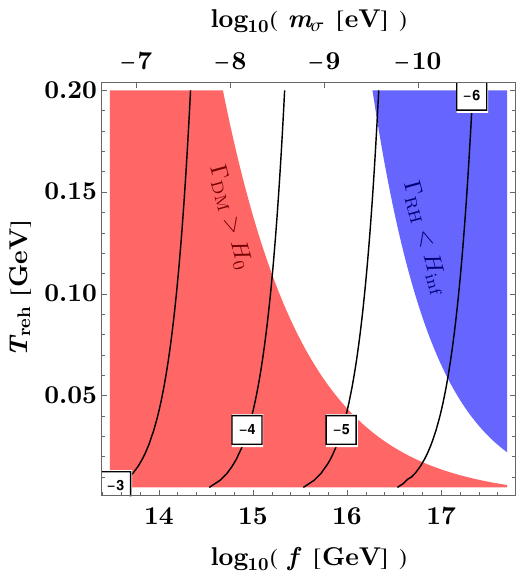
Figure 4 . Parameter space of the QCD axion in terms of its decay constant f , mass m σ , and reheating temperature T reh . To simplify the analyses, T reh is taken to be below the QCD scale; with such extremely low reheating temperatures, the axion window shown here should be considered as a proof of concept (see the main text for discussions). Regions where the QCD inflaxion can make up the dark matter is shown in white. The colored regions are excluded from the requirements of dark matter stability (red) and instantaneous reheating (blue). The lower end of the displayed T reh region is set by BBN. The inflaton-axion mixing constant is fixed to α = 1 / 2, and the inflaton 10 − 3 . Black solid contours show the inflaton mass in terms is coupled to fermions with g φff = 5 × ( m φ / of log 10